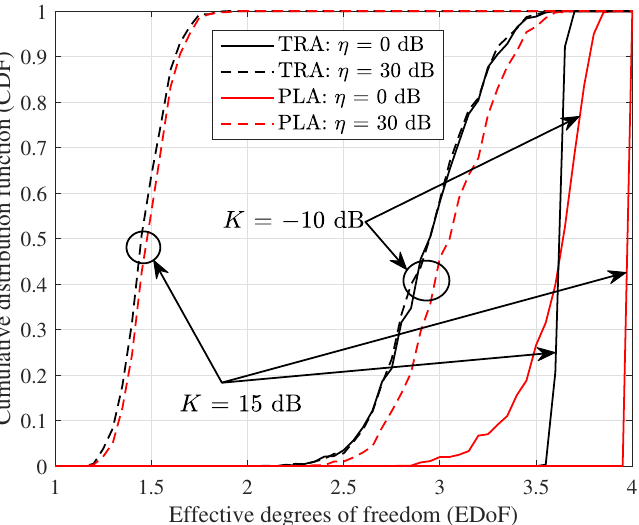
Figure 5. CDF of EDoF for different deviation factors η , and Ricean factors K with ¯ γ = 10